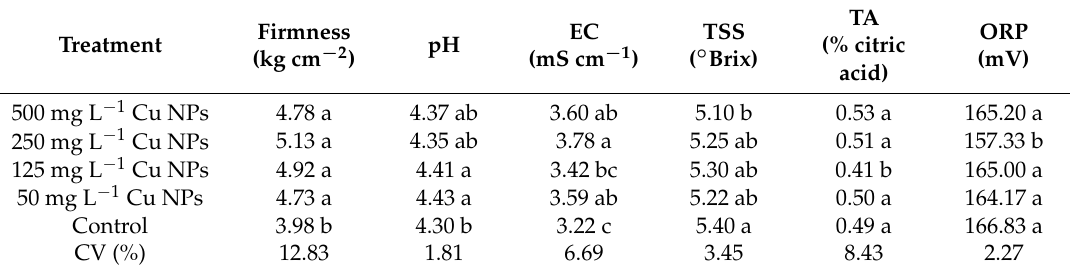
Each unit of data is the average of six replicates. CV: coefficient of variation. Different letters per column indicate significant differences between treatments according to the LSD Fisher test ( p ≤ 0.05). EC: electrical